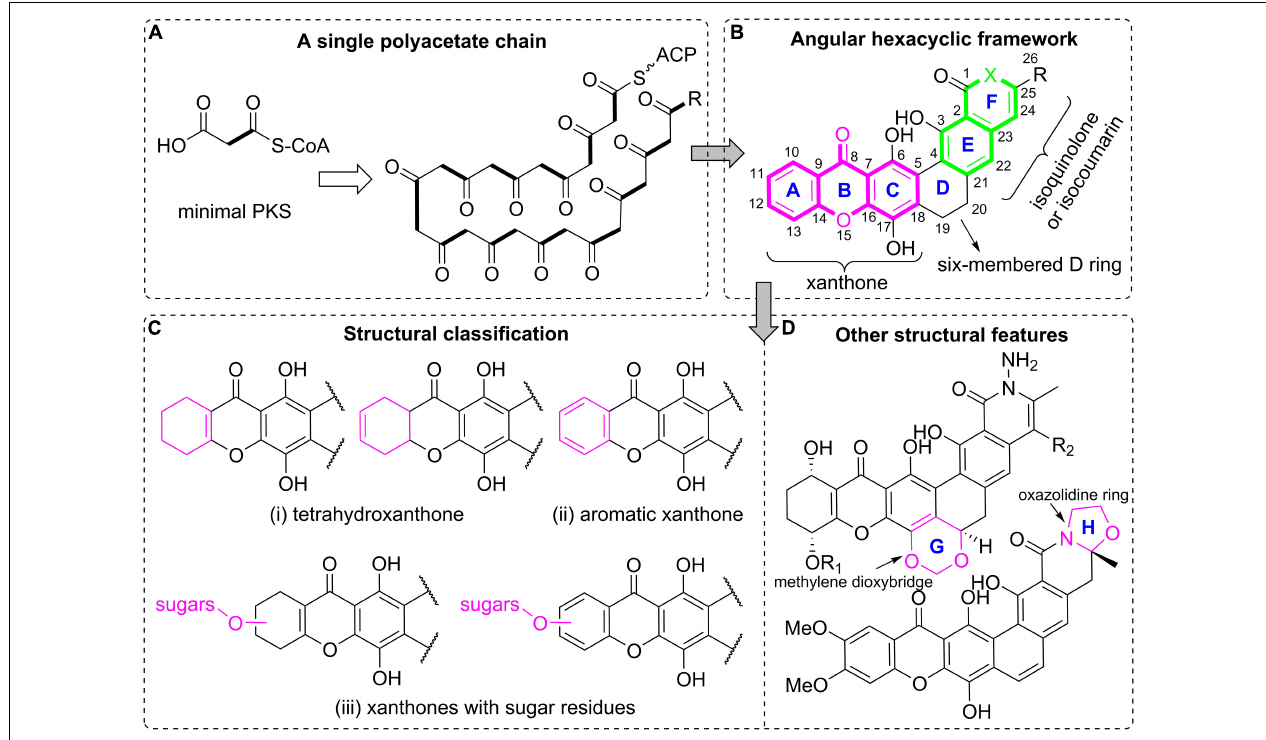
FIGURE 1 | Polycyclic xanthone natural products. (A) A single polyacetate chain as the biosynthetic precursor; (B) the general polycyclic xanthone structure with an angular hexacyclic framework; (C) structural classification based on the oxidation and substitution features of the xanthone core; (D) other structural features for further